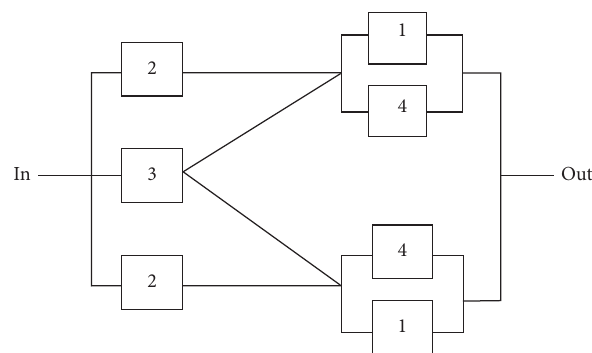
Figure 10: Example of the reliability